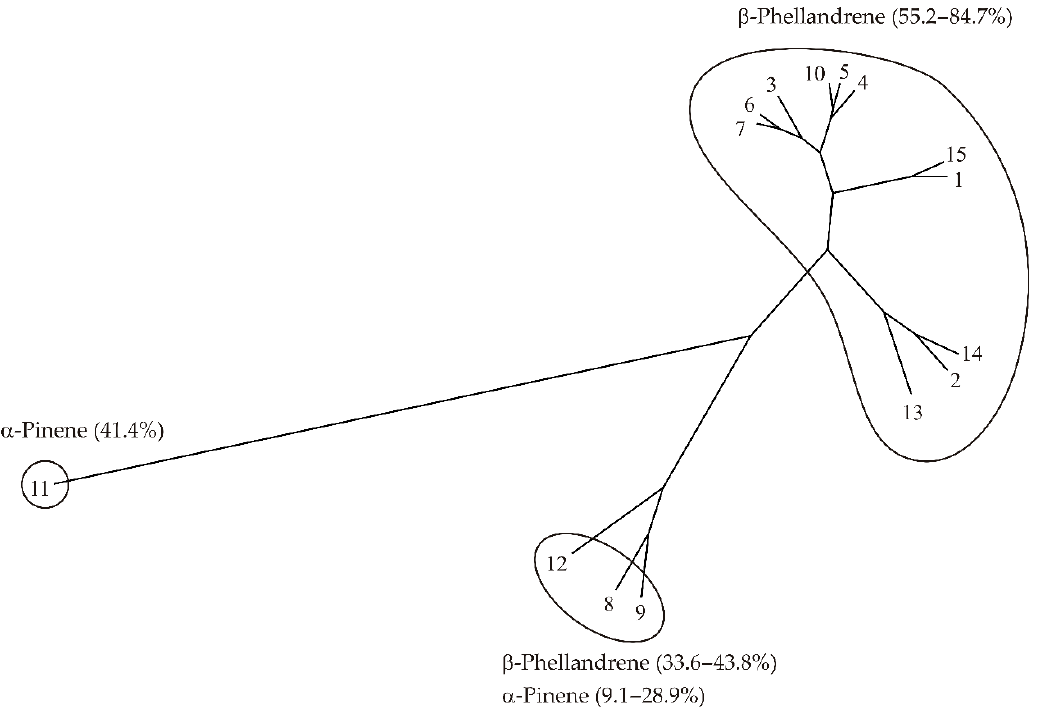
Figure 6. Unrooted cluster tree of A. archangelica seed (fruit) essential oil (samples are numbered according to Table 2).